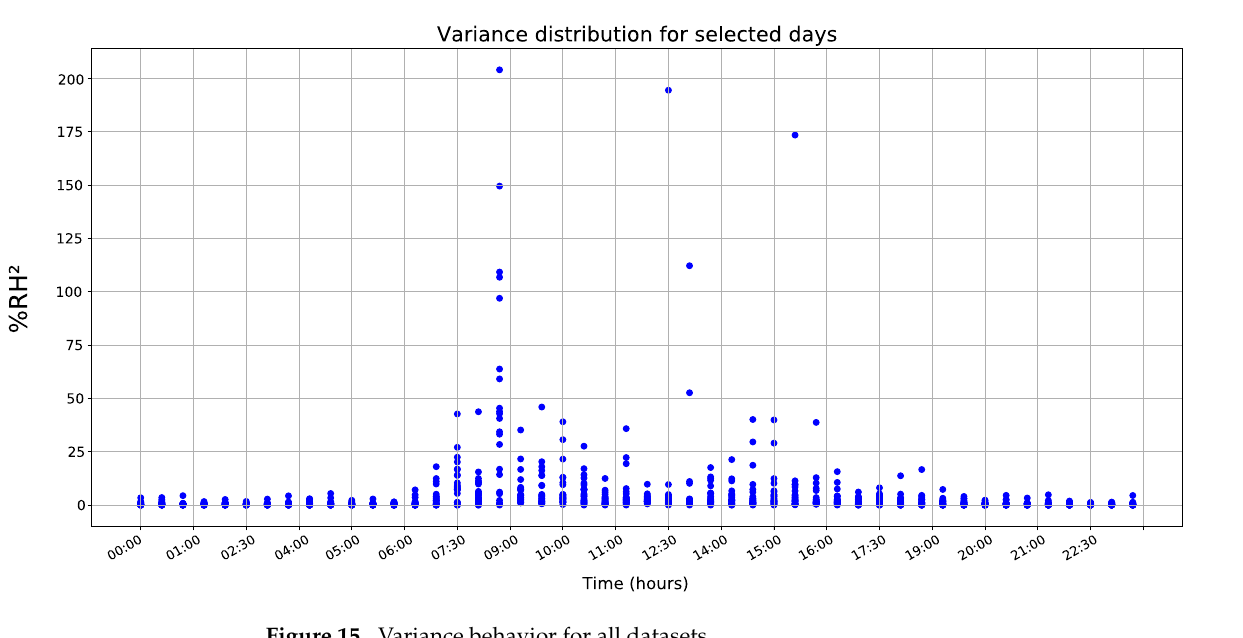
Figure 14. Humidity’s variance for different sampling times.